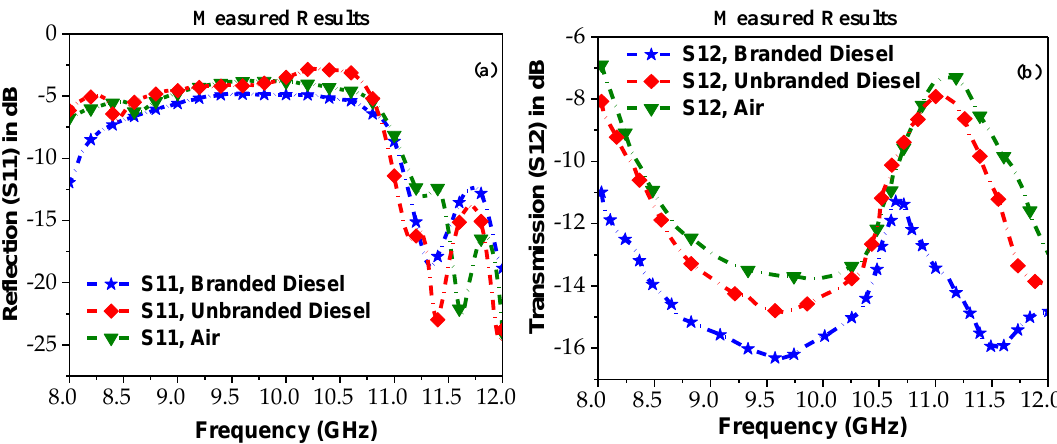
Figure 16. ( a ) Measured result of the reflection coefficient and ( b ) transmission coefficient for the empty sensing layer, branded diesel, and unbranded diesel.